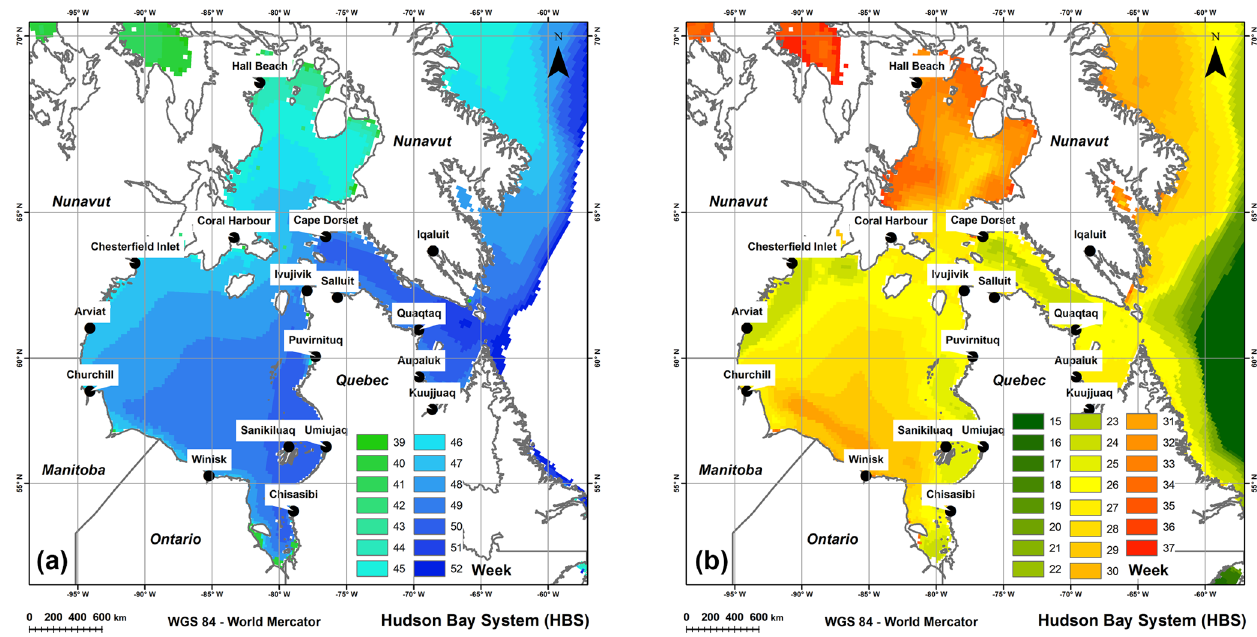
Figure 7. Frobisher Bay OSI-409 error and time concordant MODIS True Color composite (Vermote, 2017)